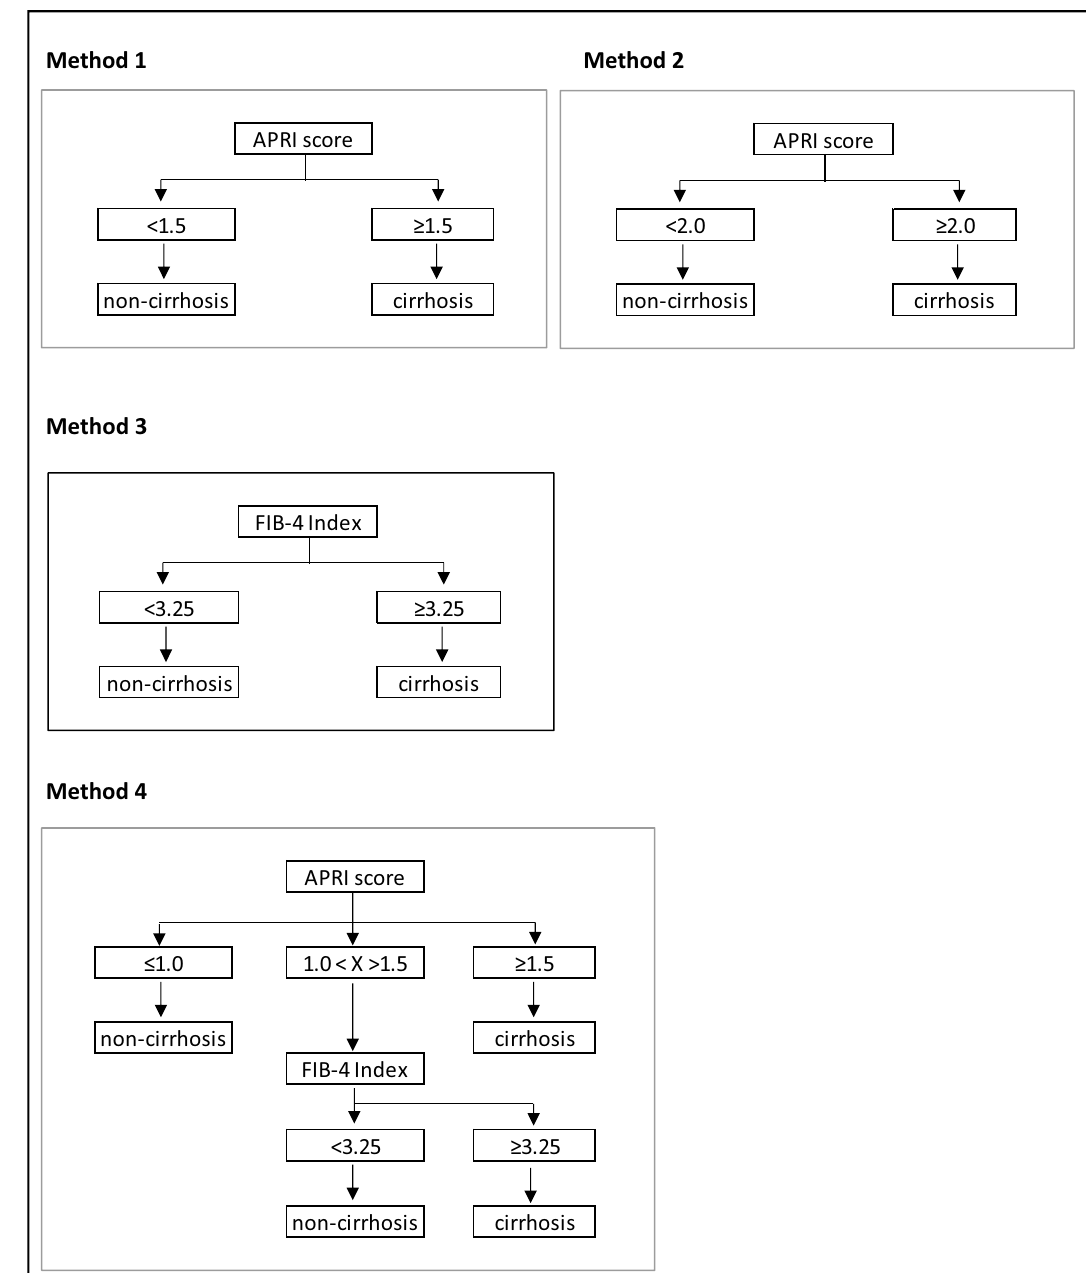
Figure 1. Methods of non-invasive biomarkers to diagnose liver cirrhosis using transient elastography as a reference standard. Method 1—APRI using a score of 1.5 as the binary cut-off. Method 2—APRI using 2.0 as the binary cut-off. Method 3—FIB-4 Index using 3.25 as the binary cut-off. Method 4 (the sequential combination method) –The cirrhosis status of those with an APRI score between 1.0 and 1.5 were reassessed using FIB-4 score. APRI aspartate-to-platelet ratio index, FIB-4 fibrosis 4